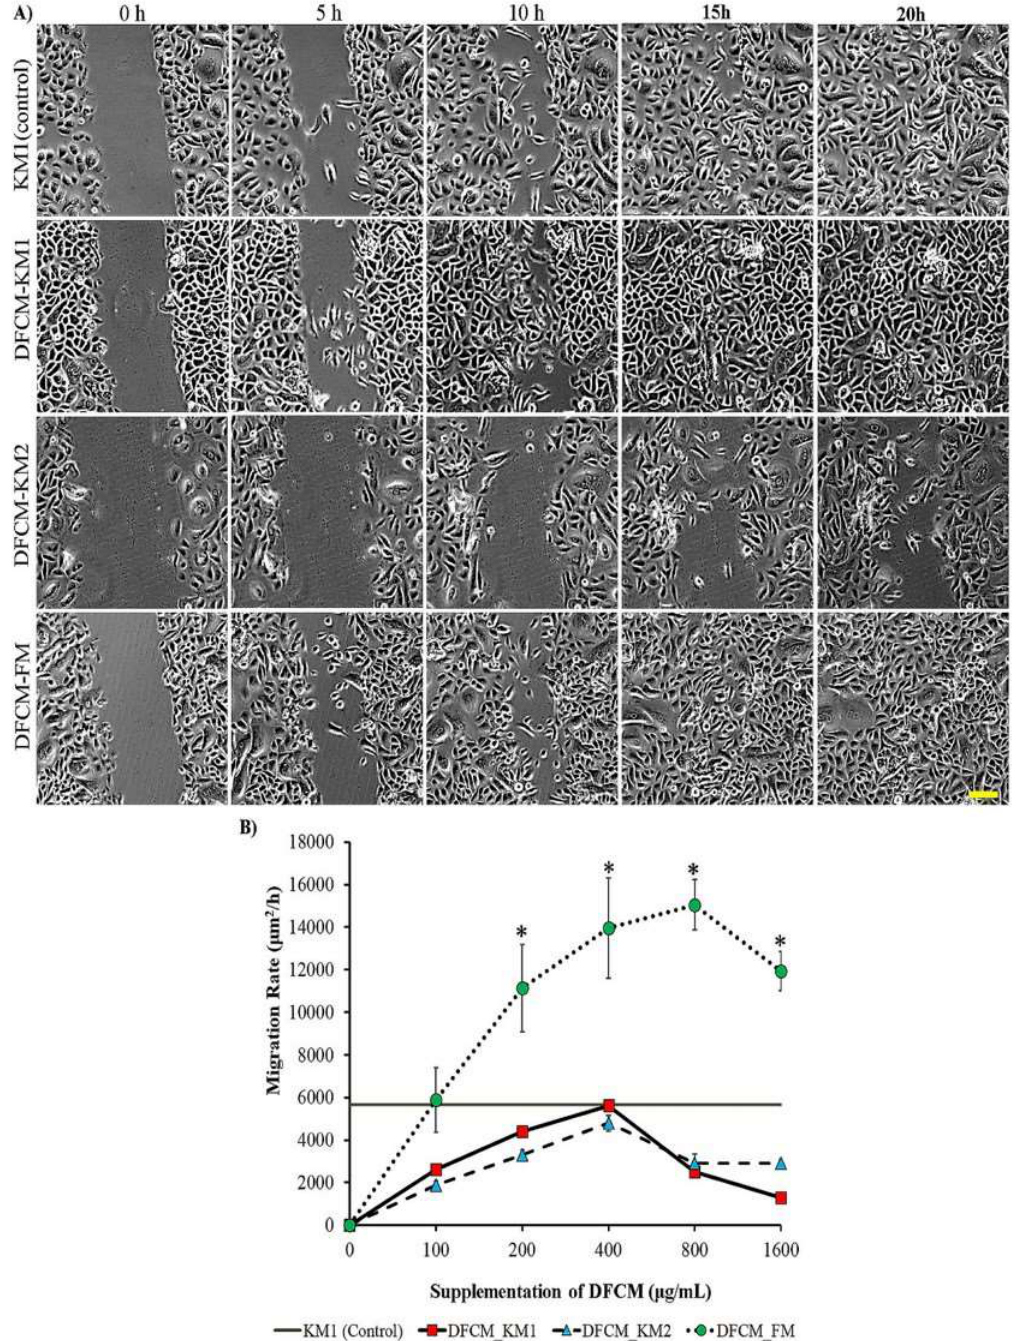
Figure 4. The effect of DFCM on keratinocyte wound healing. ( A ) The images of keratinocyte scratch assay supplemented with 400 µg/mL DFCM; scale bar is 100 µm. ( B ) Migration rate for wound healing assay. Here, * represents significantly higher migration rate in the DFCM-FM group than in the other groups ( p < 0.05) ( n = 3). Scale bar = 100 µm.